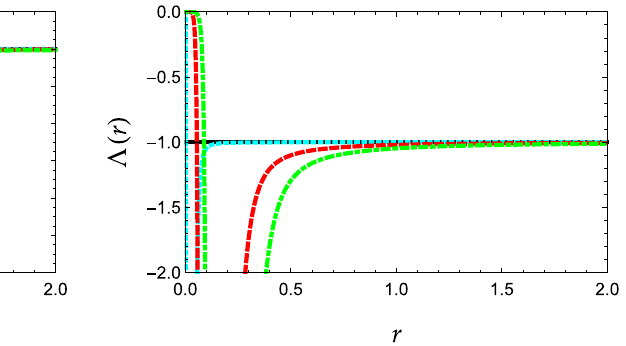
G 0 = 1 , M 0 = 1 and (cid:9) 0 = 1. The color code is as follows: (i) solid black line, for ξ = 0, (ii) dotted blue line, for ξ = 0 . 010, (iii) dashed red line, for ξ = 0 . 100, (iv) dot-dashed green line, for ξ = 0 .